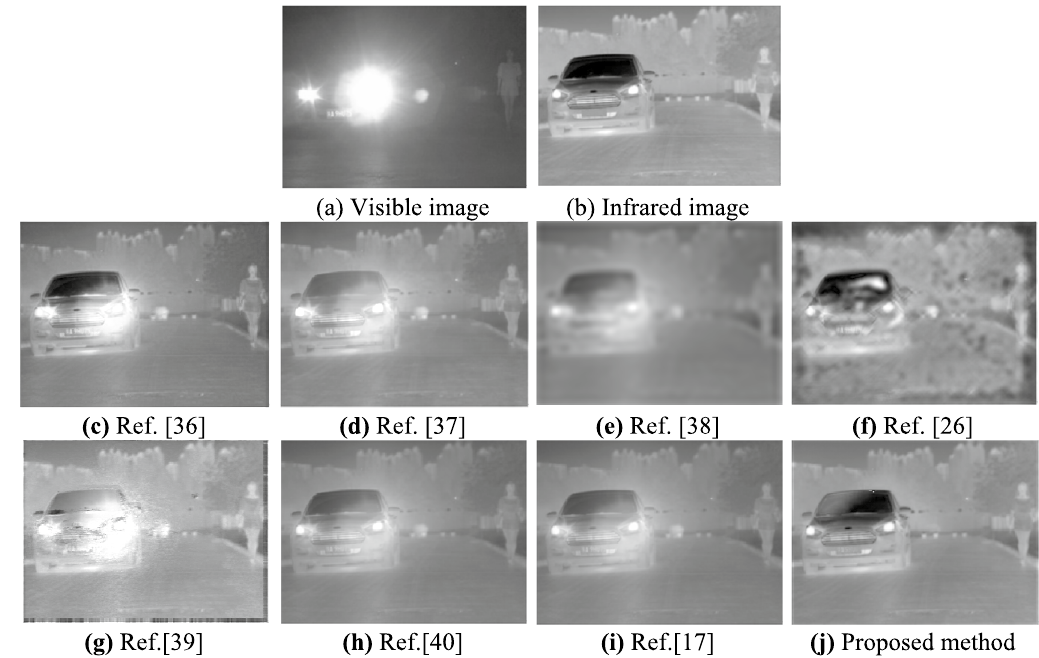
Figure 7. Visible and infrared images (RCHE) and their fusion